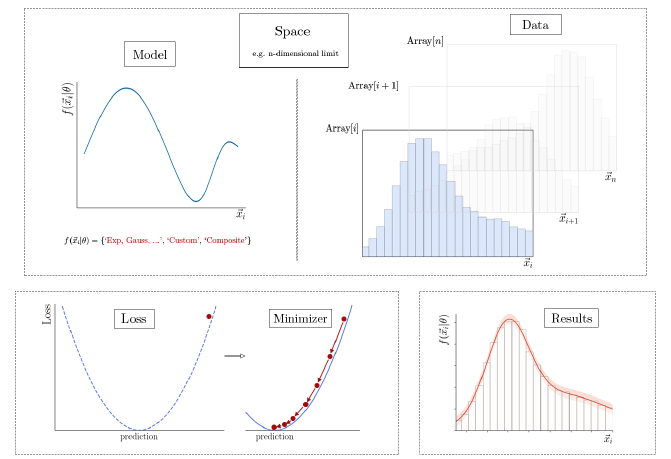
Figure 1. Workflow of zfit. Data is loaded and a model built, each one in the same space. Both together combine to a loss, which is minimized by the minimizer. The result allows to do basic error